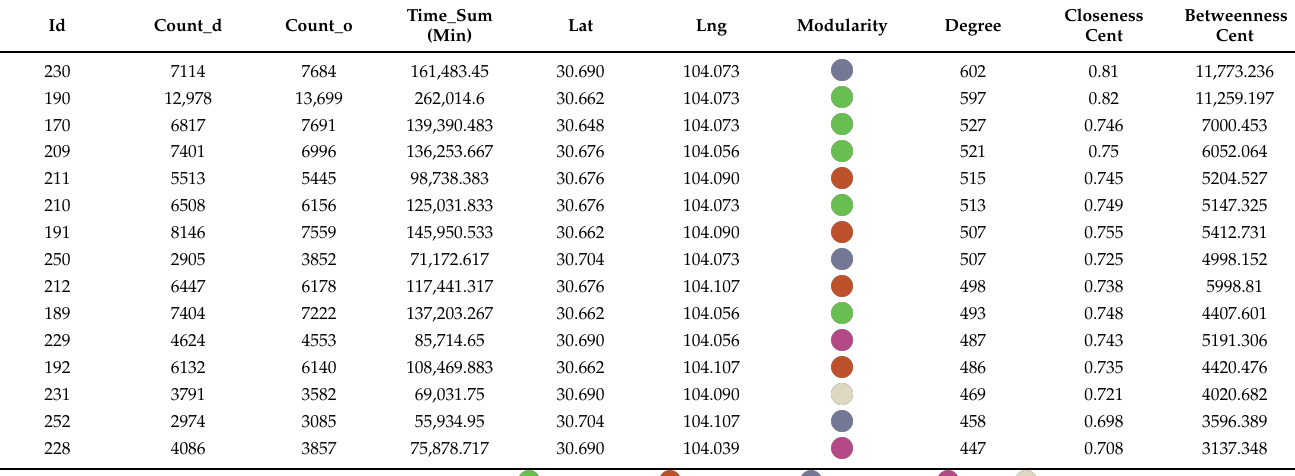
Figure 10. Network node degree display. (The location degree values are higher for node IDs around 200 near the city center, which is consistent with the results of Figure 8, where the nodes in the city center have the most traffic and show scale-free characteristics). Table 1. Calculation results of complex network